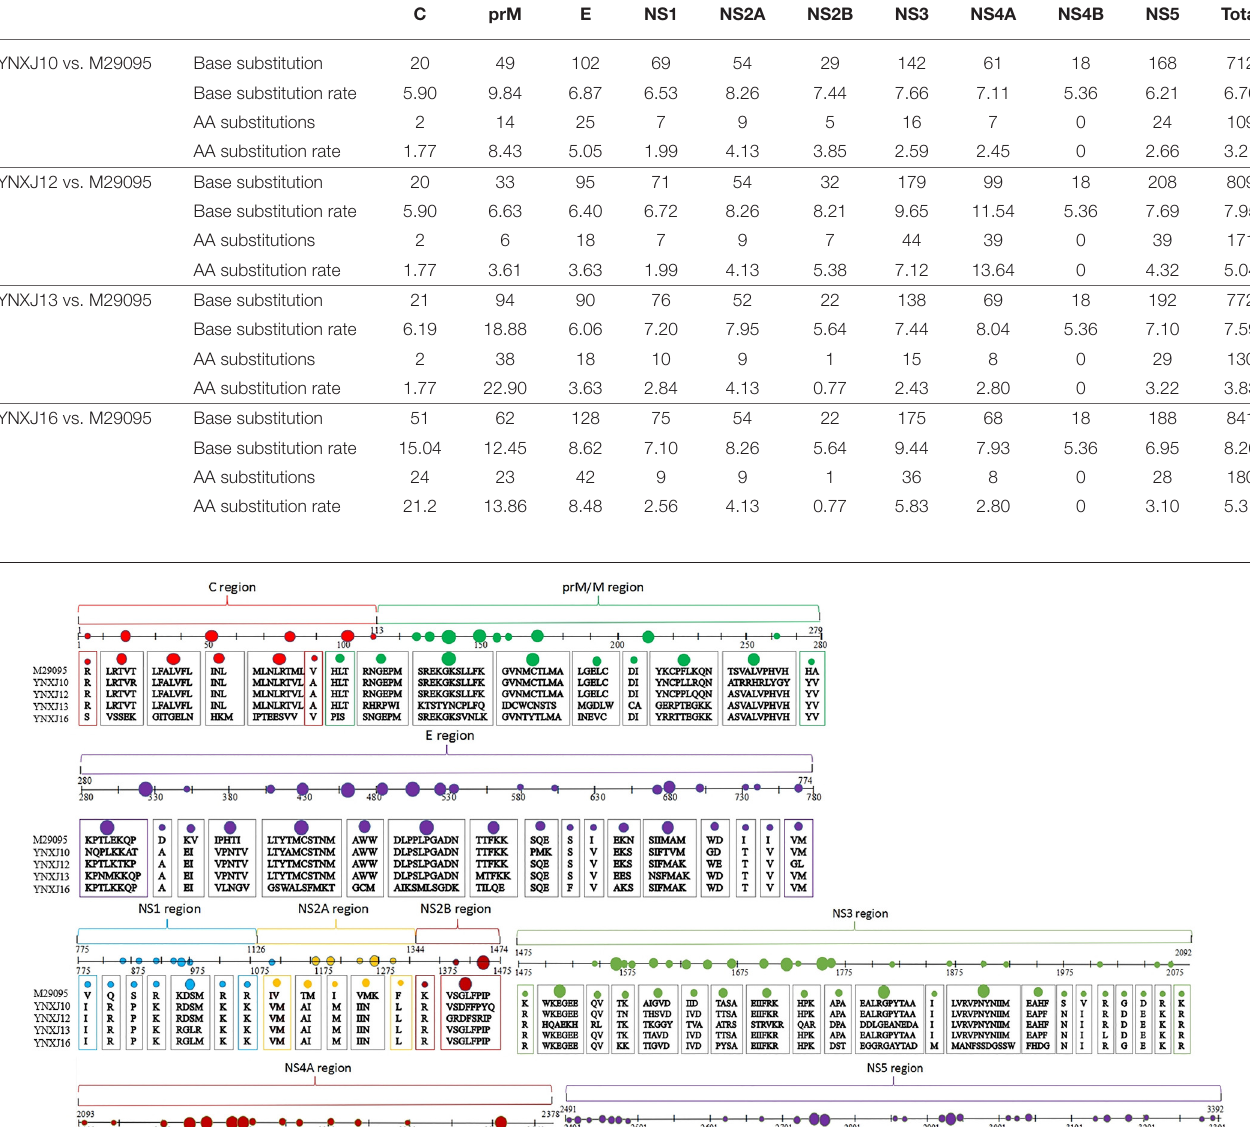
TABLE 2 | Amino acid substitutions in the translated regions.